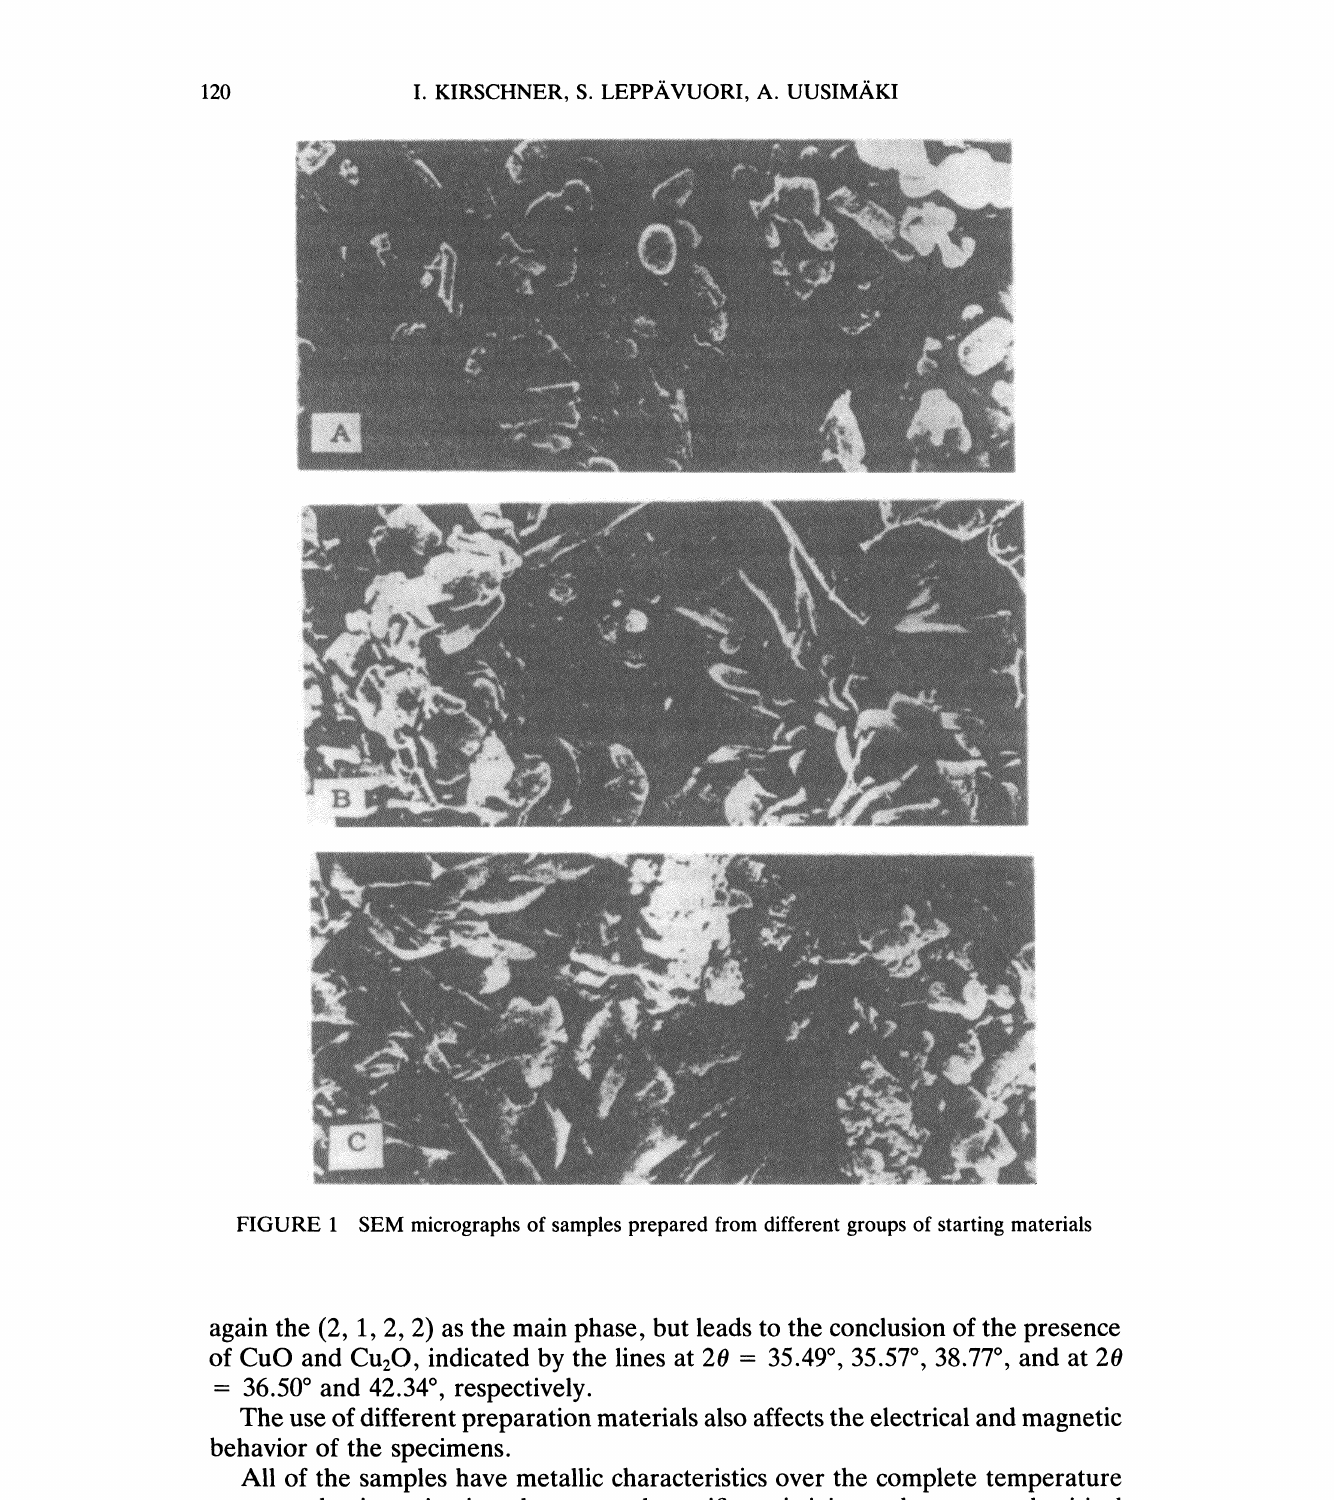
, , , 38.77 35.57 and at 20